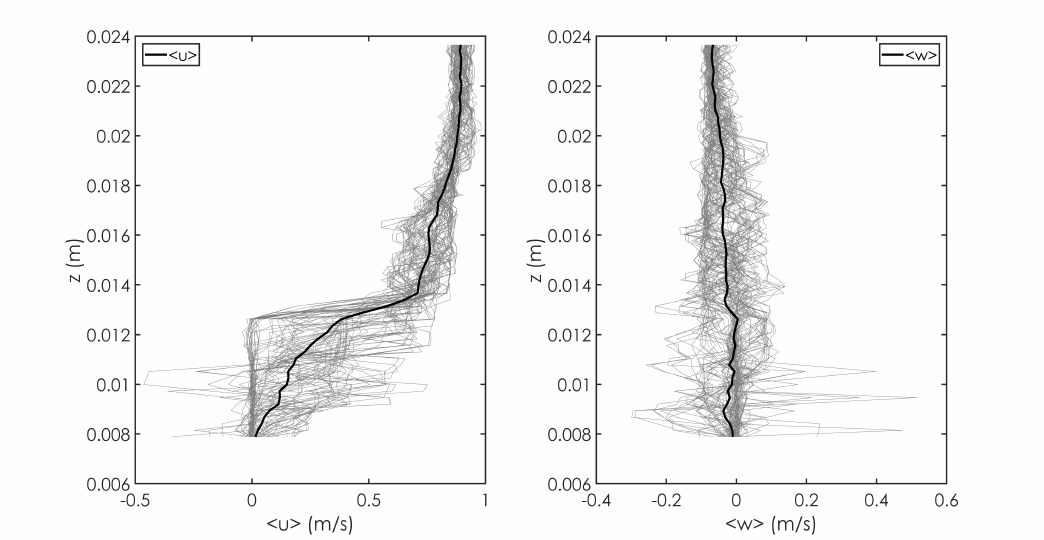
Figure 15. Instantaneous velocity profiles used to compute the spatial mean velocity (solid black line) in the region of interest (Figure